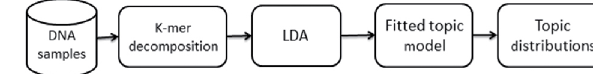
Figure 2: LDA process steps in our